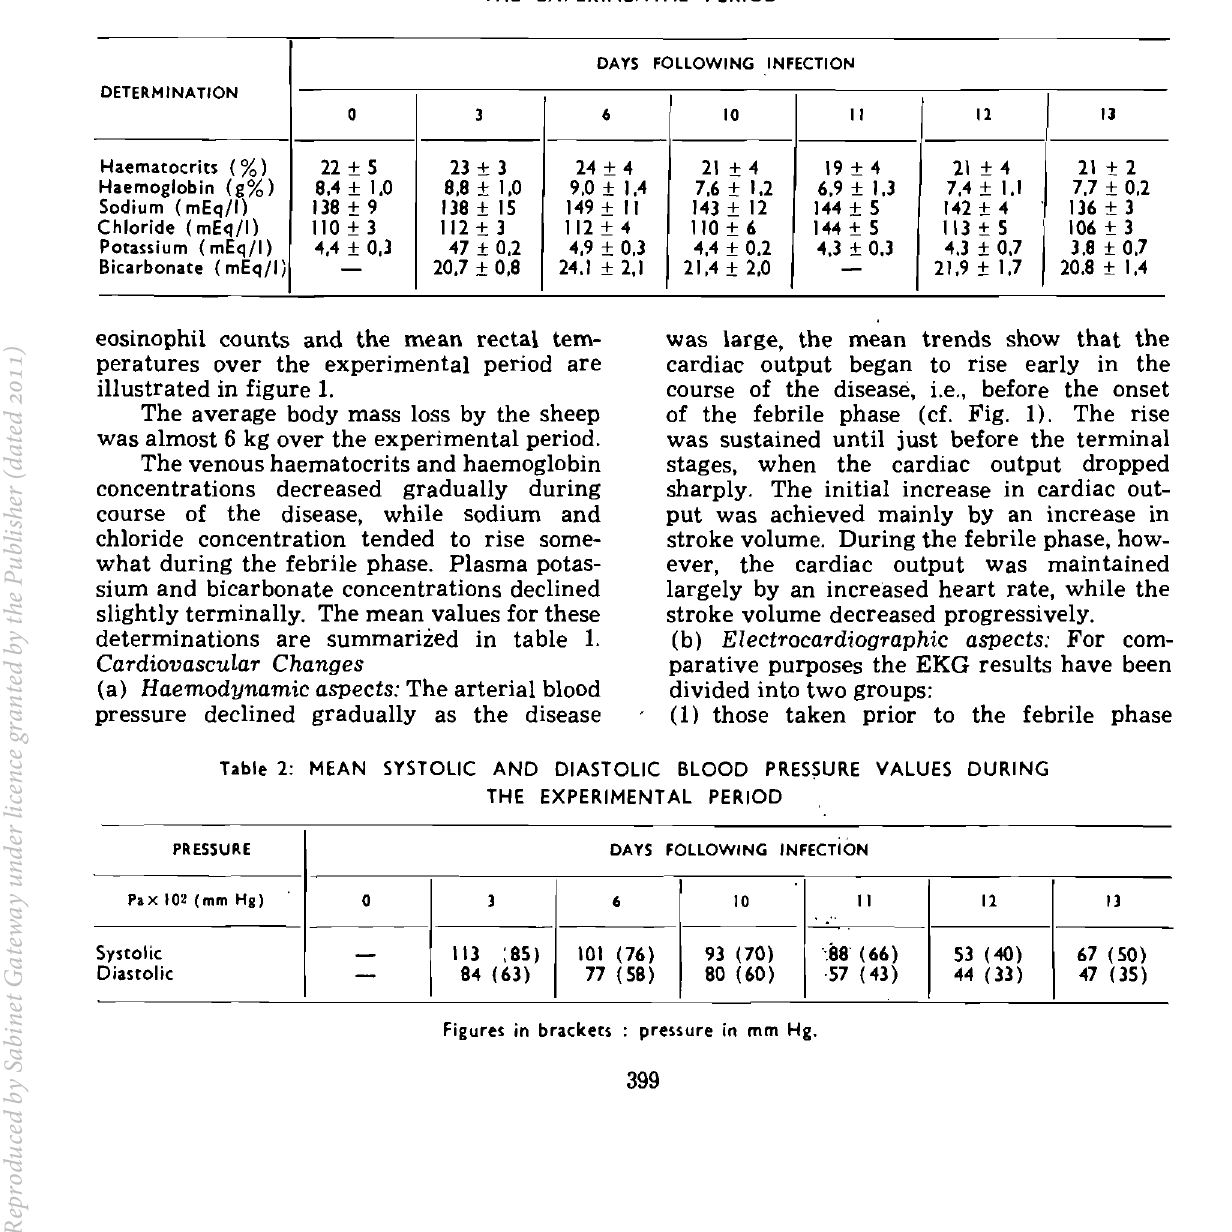
Table 1: MEAN VALUES (± I SD) OF DIFFERENT BLOOD CONSTITUENTS DURING THE EXPERIMENTAL PERI6D DAYS FOLLOWING INFECTION